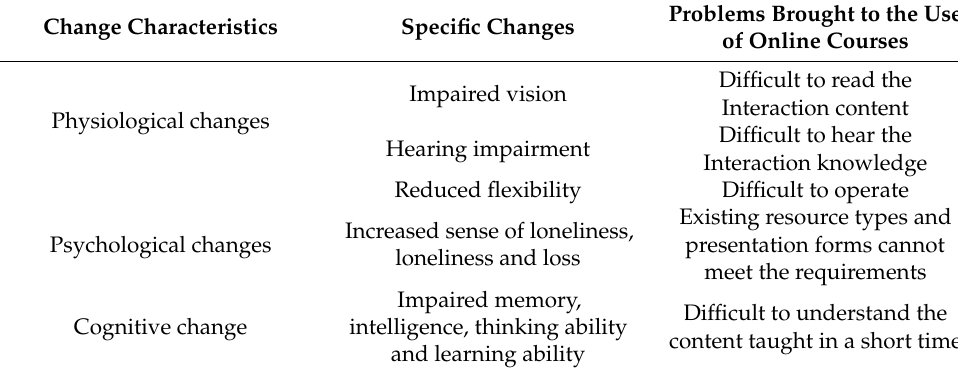
Table 1. Changes in the characteristics of older adults and their distress about using online courses.